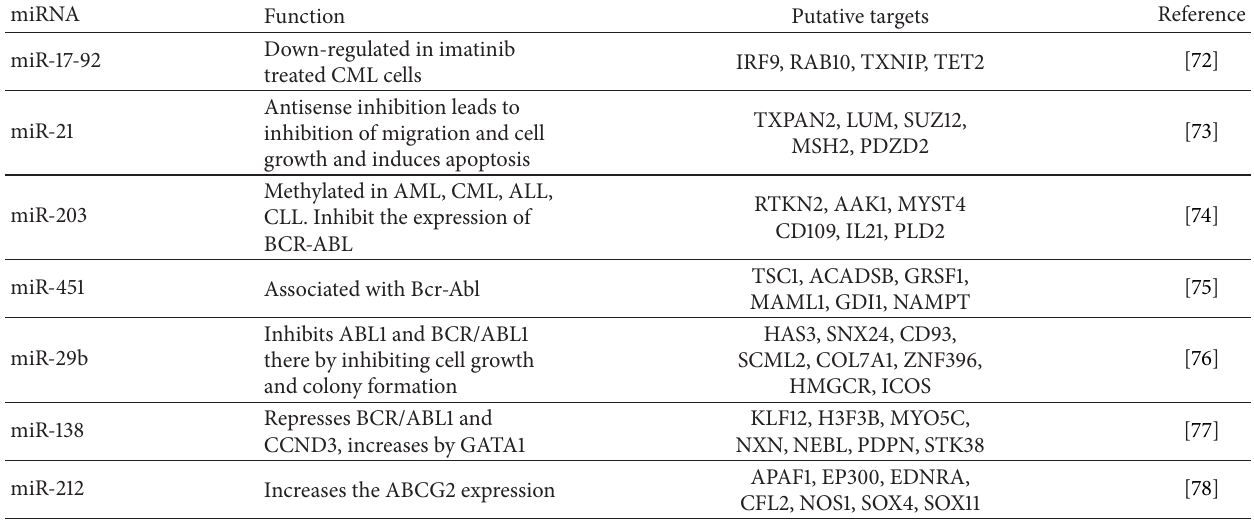
Table 7: miRNAs involved in